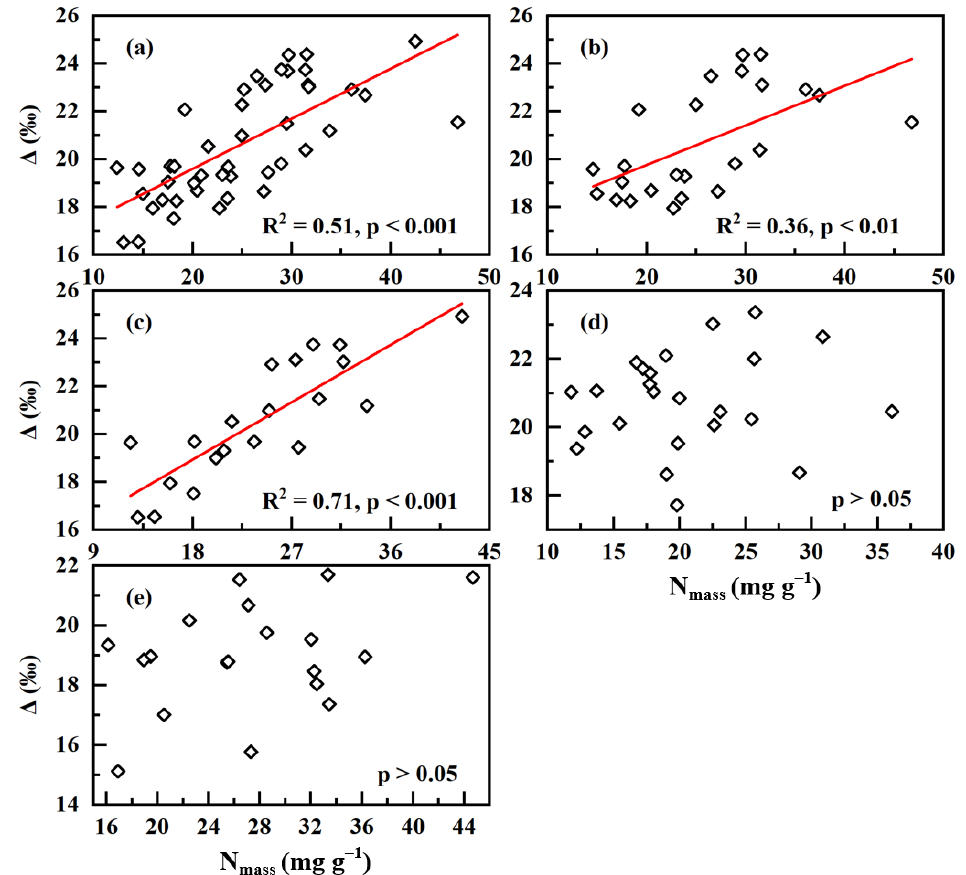
Figure 1. Relationship between leaf N based on mass (N mass ) and carbon-isotopic discrimination (∆) at the community level for plants derived from the first sampling campaign: ( a ) Baiwangshan mountain; ( b ) the sunny slope of Baiwangshan mountain; ( c ) the shaded slope of Baiwangshan mountain; and ( d ) Luochuan, ( e ) Shapotou.